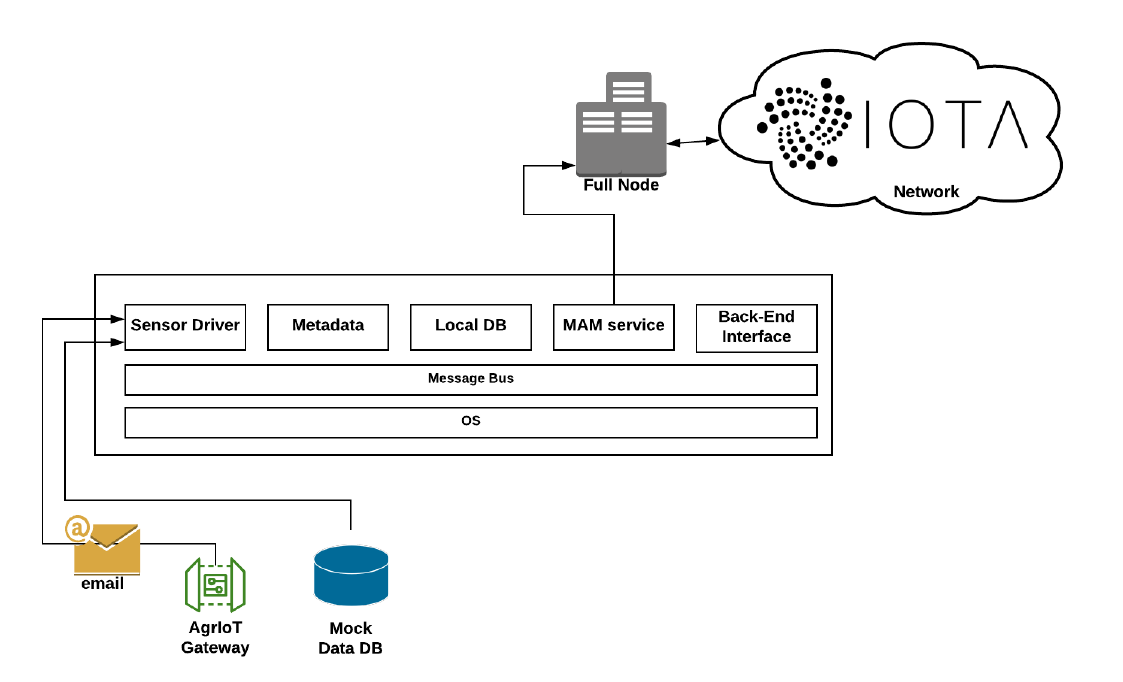
Figure 10. The Edge Super Node